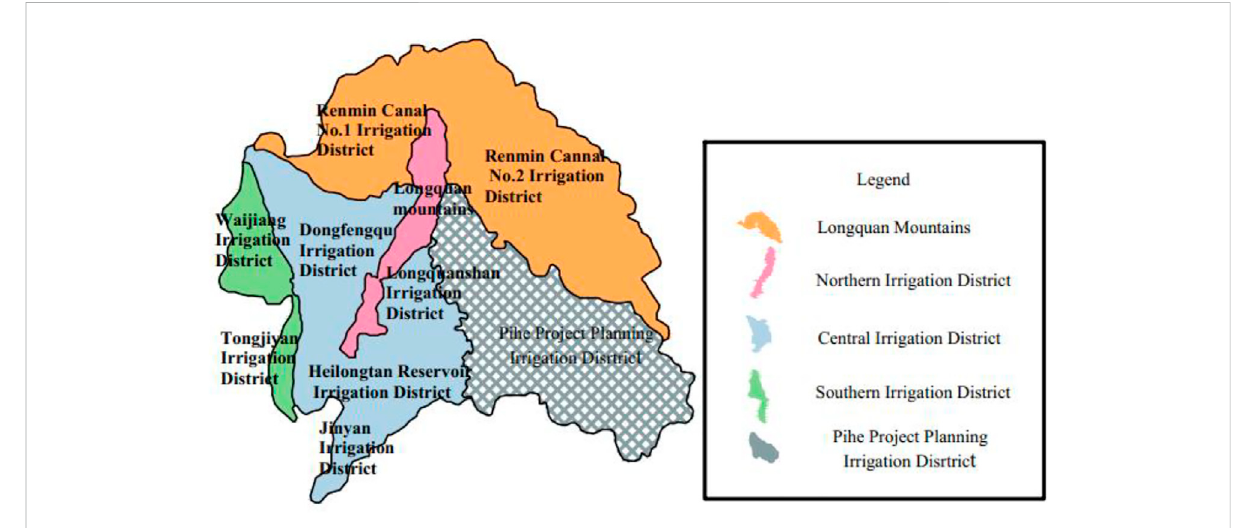
FIGURE 3 Composition map of the Dujiangyan Irrigation